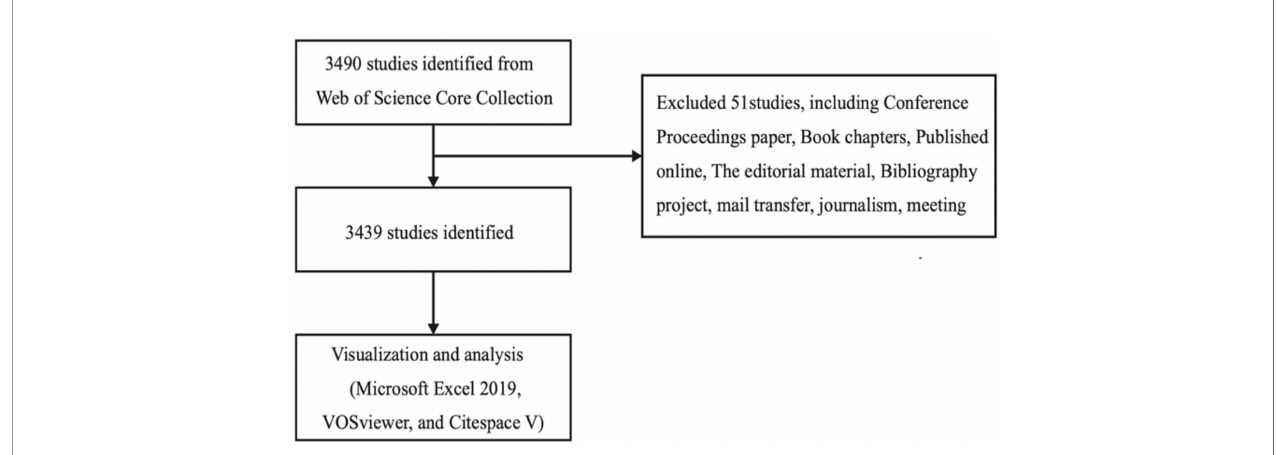
FIGURE 1 | Flow chart of